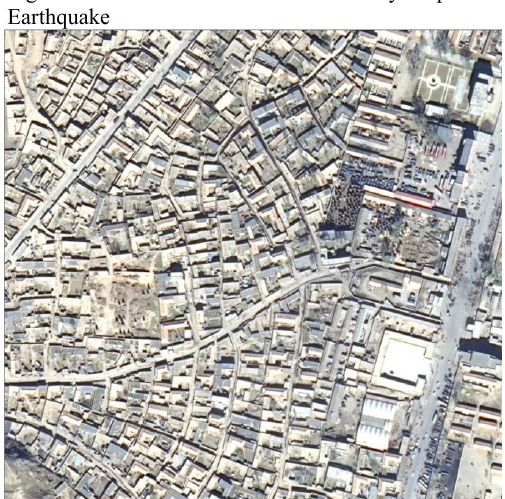
Figure 3: the distribution map of affected population based on rapidly assessed seismic intensity